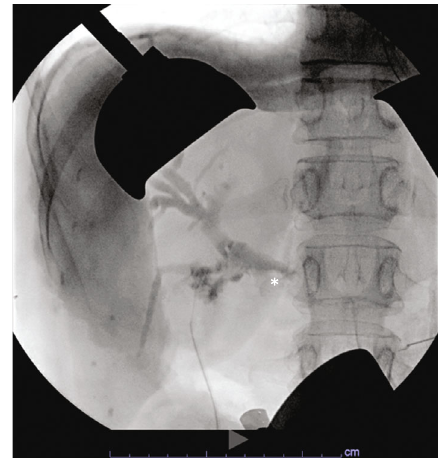
Figure 3: Intraop cholangiogram to delineate biliary anatomy. The asterisk marks the impacting CBD stone.